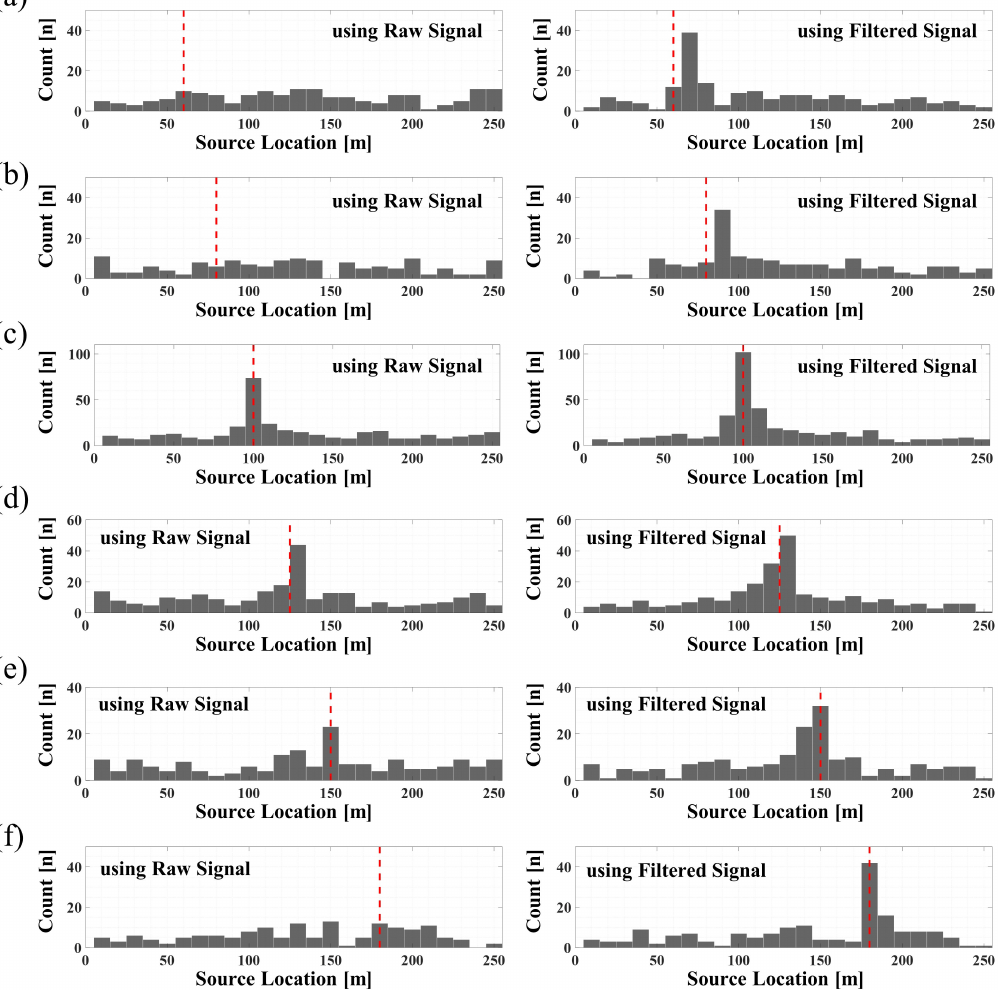
Figure 21. Results of source location comparisons of raw signal and filtered signal: ( a ) results of the excavation test at 60 m, ( b ) results of the excavation test at 80 m, ( c ) results of the excavation test at 100 m, ( d ) results of the excavation test at 120 m, ( e ) results of the excavation test at 150 m, and ( f ) results of the excavation test at 180 m .